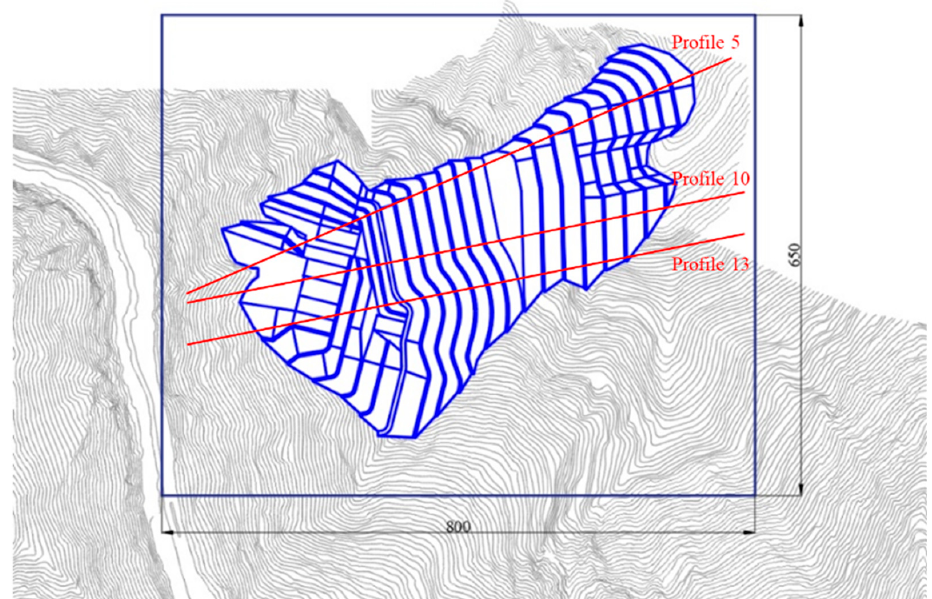
Figure 4. Modeling range and typical profile location.